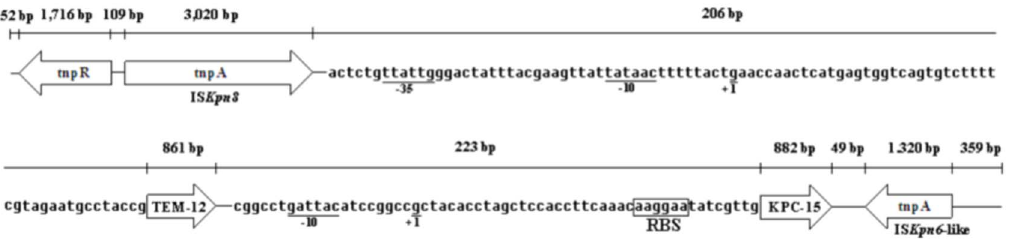
Figure 3. Promoter elements of the bla KPC-15 and bla TEM genes in 8.997 kb-length nucleotide sequence. The sequence provided the upstream and downstream regions of bla KPC-15 structural genes. The tnpA gene, which was upstream of the bla KPC-15 (3,020 bp) gene, was homologous to a putative IS Kpn8 transposon, and the downstream region of the bla KPC-15 gene (1,320 bp) was homologous to a putative IS Kpn6 -like transposon. The nucleotides upstream of the bla KPC-15 and bla TEM-12 gene translational start codons were shown in the box. The putative 2 10 promoter elements of the bla KPC-15 gene were shown as gattaa , labeled as 2 10 below, and there were no obvious 2 35 promoter elements to be discovered in the promoter region. The putative 2 10 and 2 35 promoter elements of the bla TEM-12 gene were shown as tataac and ttattg , labeled as 2 10 and 2 35 below the promoter region. The start sites of transcription were indicated as G by + 1 residue. RBS was the abbreviation of the ribosome binding